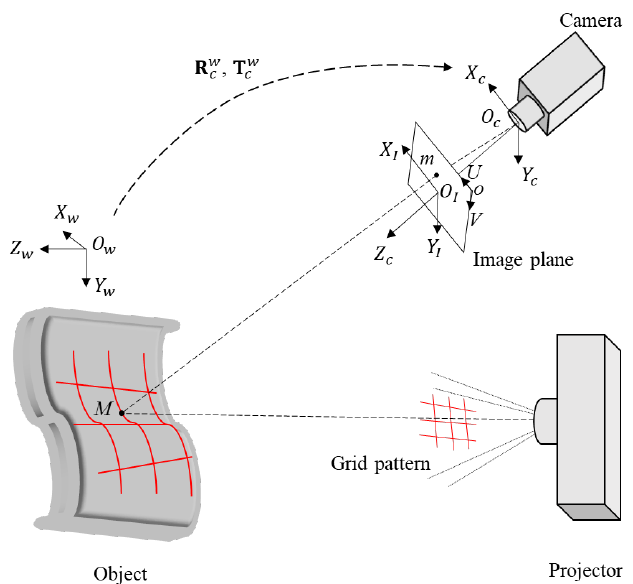
Figure 1. Schematic diagram of the SL system using grid pattern.